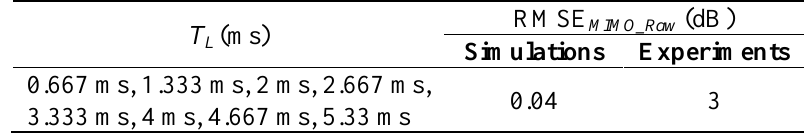
as a function of T . MIMO_Raw L